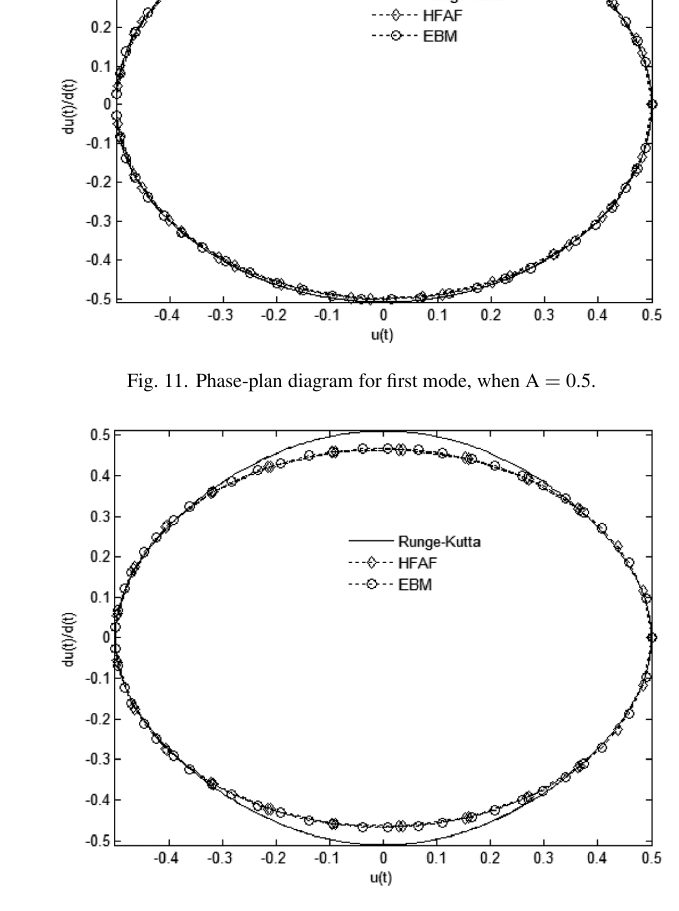
Fig. 12. Phase-plan diagram for second mode, when A =